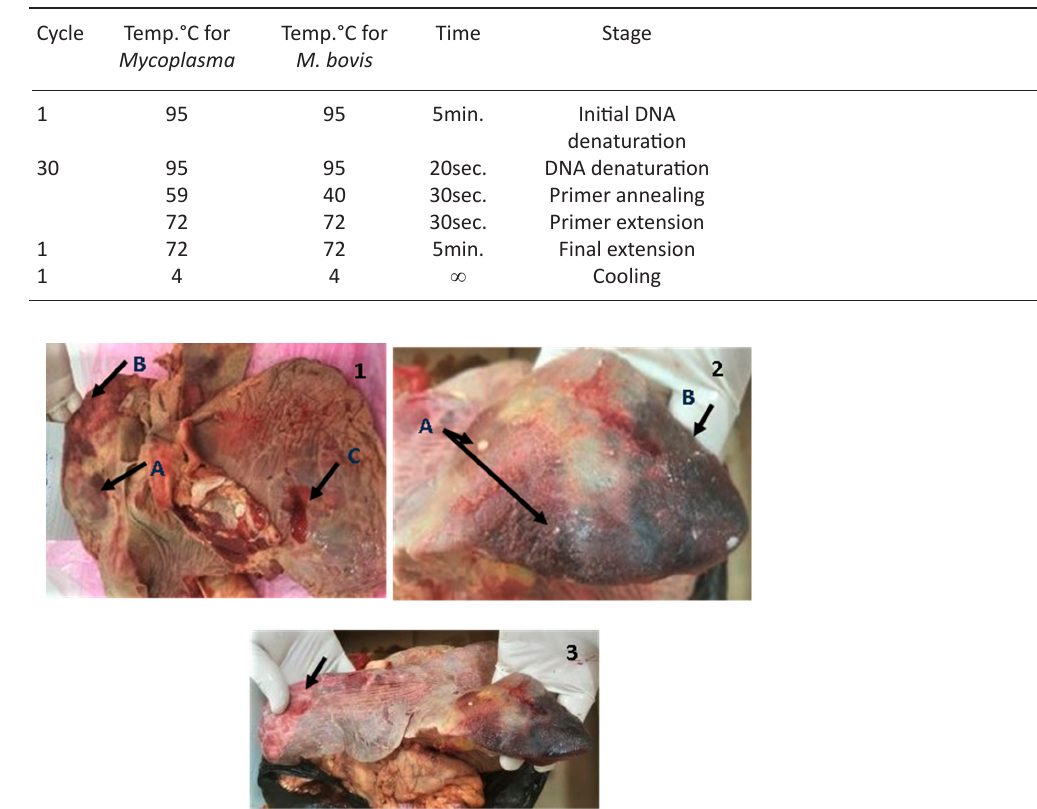
Fig. 1-3. Lung suspected to be infected with bovine